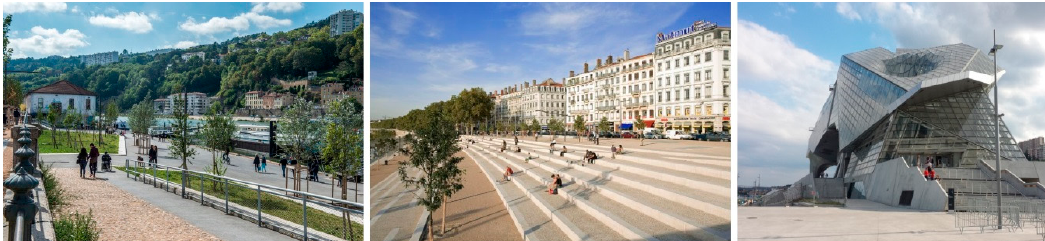
Figure 14. Left : Landscaping in Confluence for sustainable stormwater management (Laurence Danière/SPL Lyon Confluence, 2017); Middle : Dock bleachers made of white stone and deactivated concrete; Right : Square in front of the Confluence Museum, without any vegetation and shade (source: Quentin Lafont).